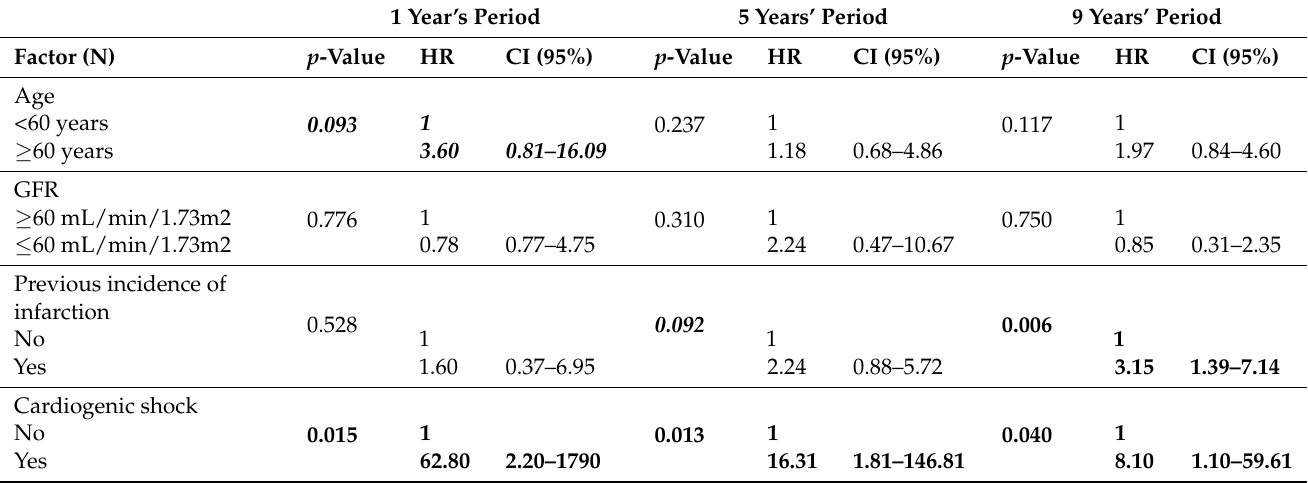
Table 8. Multivariate Cox’s proportional analysis for 1-year, 5-year and 9-year survival periods of patients with acute coronary